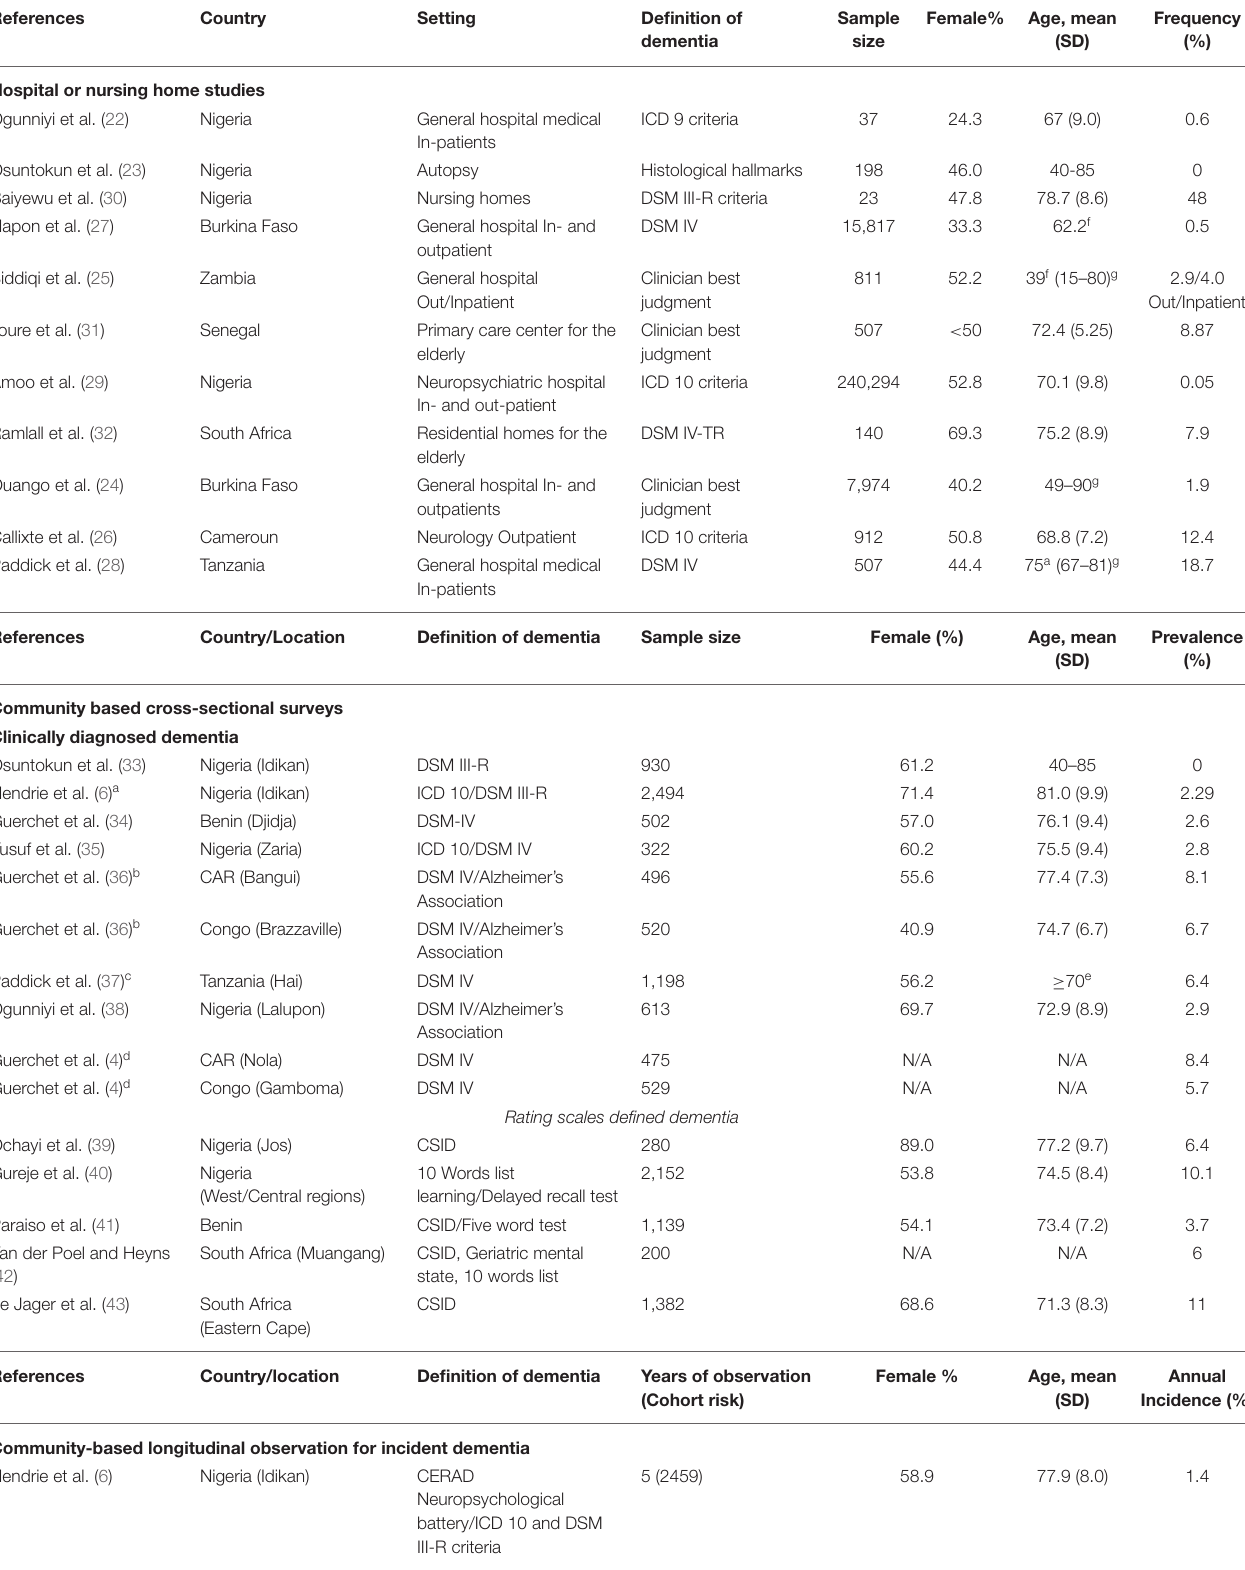
TABLE 1 | Characteristics of studies of prevalence and incidence of dementia in sub-Saharan